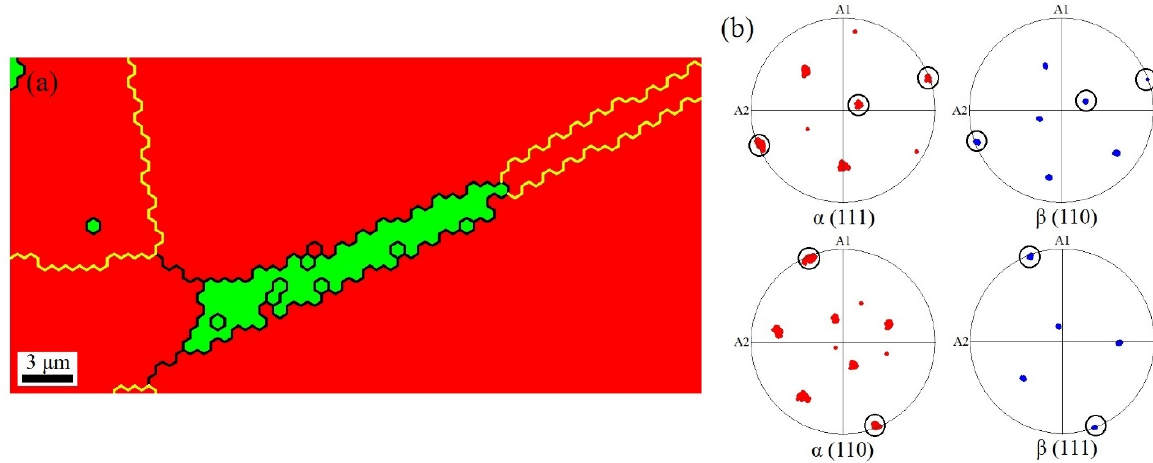
Figure 6. ( a ) Formation of β phase at Σ 3 twins boundaries at higher magnifications. ( b ) (110) and (111) pole figures of α and β (formed at Σ 3 twins boundaries) phases near the interfacial areas.